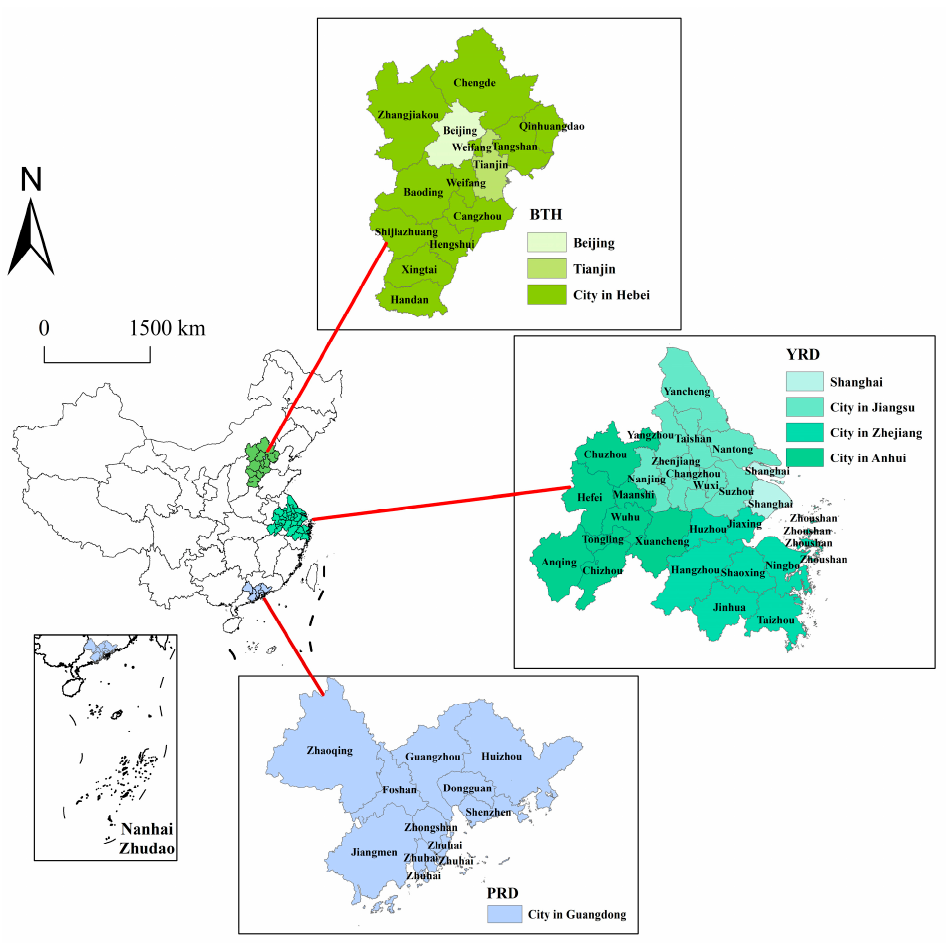
Figure 1. The location of each city in the three major urban agglomerations.